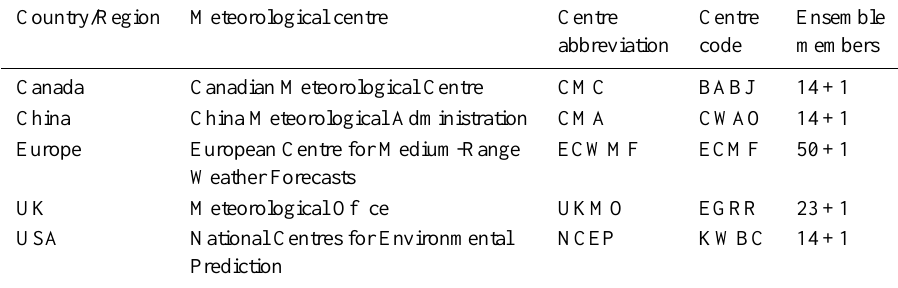
Table 1. List of the meteorological forecast centres used in the case study. Country/Region Meteorological centre Centre Centre